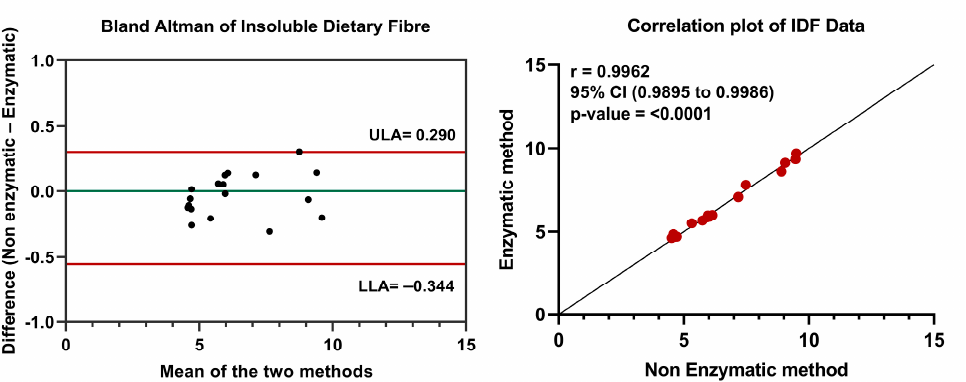
Figure 1. Comparison of IDF data from enzymatic and non-enzymatic methods. Bland–Altman plot was created by plotting the average and difference between the enzymatic and non-enzymatic methods. LA—Upper limit of agreement; LLA—Lower limit of agreement. Pearson’s correlation coefficient was calculated for IDF data. Statistical significance was set at p -value ≤ 0.05.